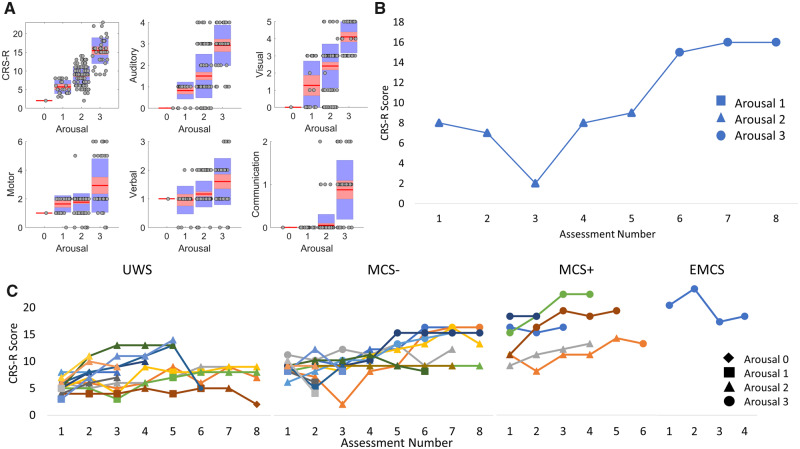

Arousal as an important predictor of recovery. (A) Boxplots illustrating the total CRS-R scores and the subscale scores associated with each categorical score on the arousal subscale. The plots demonstrate that higher scores on all the subscales typically occur at highest arousal scores. (B) Example of an (initially) MCS− patient that shows higher CRS-R scores at later assessments (6–8) that coincides with higher scores on the arousal subscale. (C) Individual CRS-R score trajectories across assessments for each patient grouped by Initial diagnosis. Individual patients’ trajectories are represented by different coloured lines. For most patients, there are clearly higher CRS-R scores when the arousal subscale score is also higher. CRS-R scores are typically higher for later assessments and those later CRS-R scores are higher for patients with an MCS or EMCS initial diagnosis.